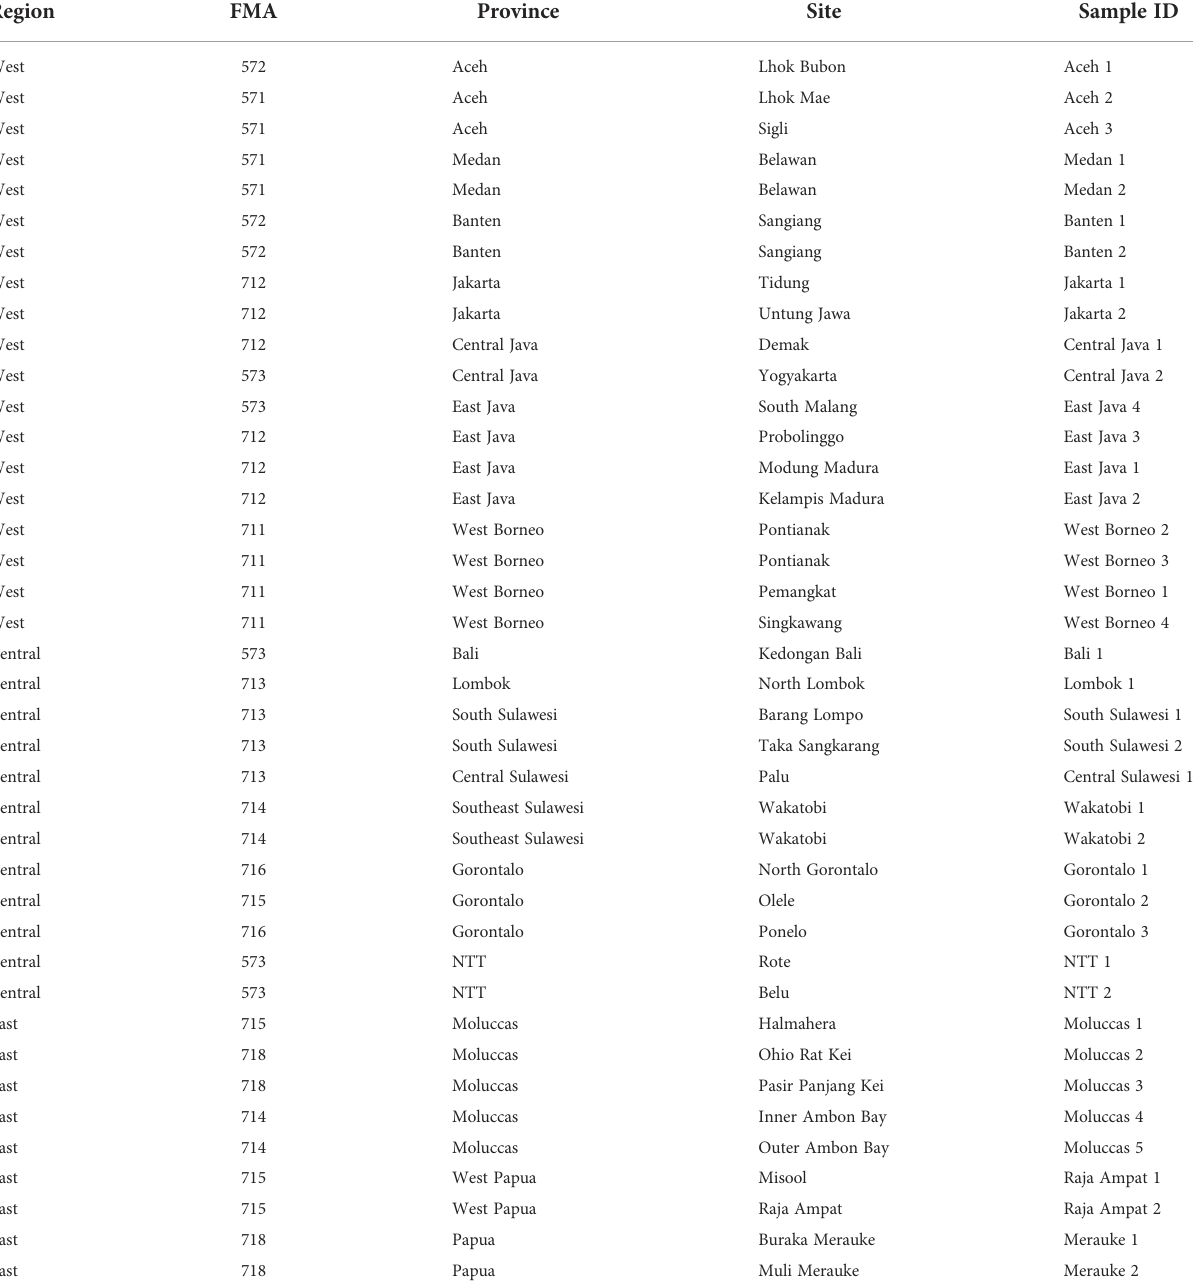
TABLE 2 Summary of eDNA seawater sampling sites across Indonesia by